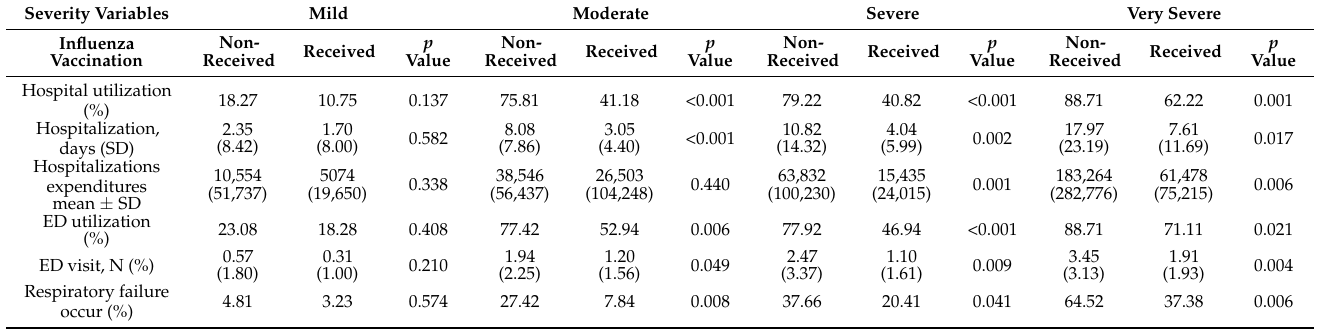
Table 2. Effectiveness of influenza vaccination measured by rates of medical utilization in COPD patients with different severities of airflow obstruction.